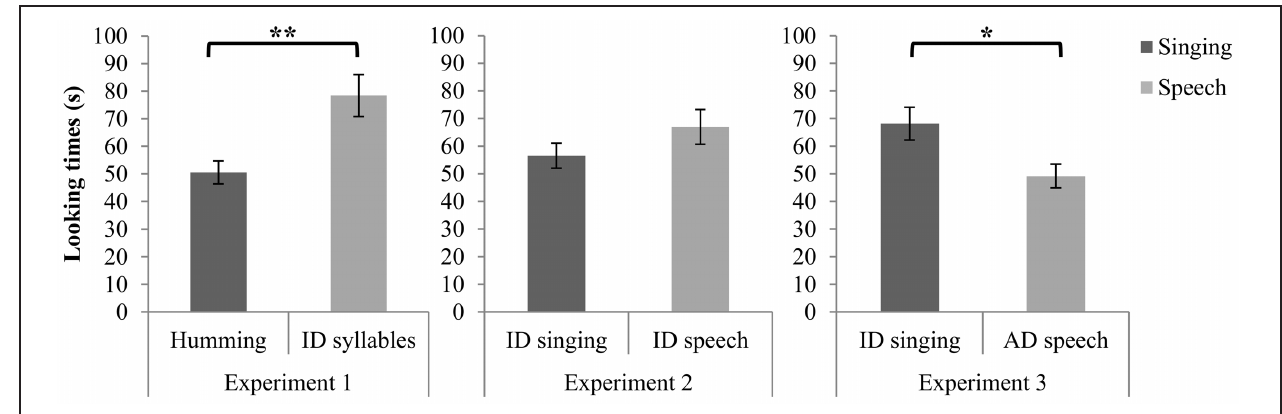
FIGURE 2 | Cumulative looking time in seconds (s) for singing and speech. Error bars are standard errors ( ∗∗ p < 0 . 01; ∗ p < 0 .